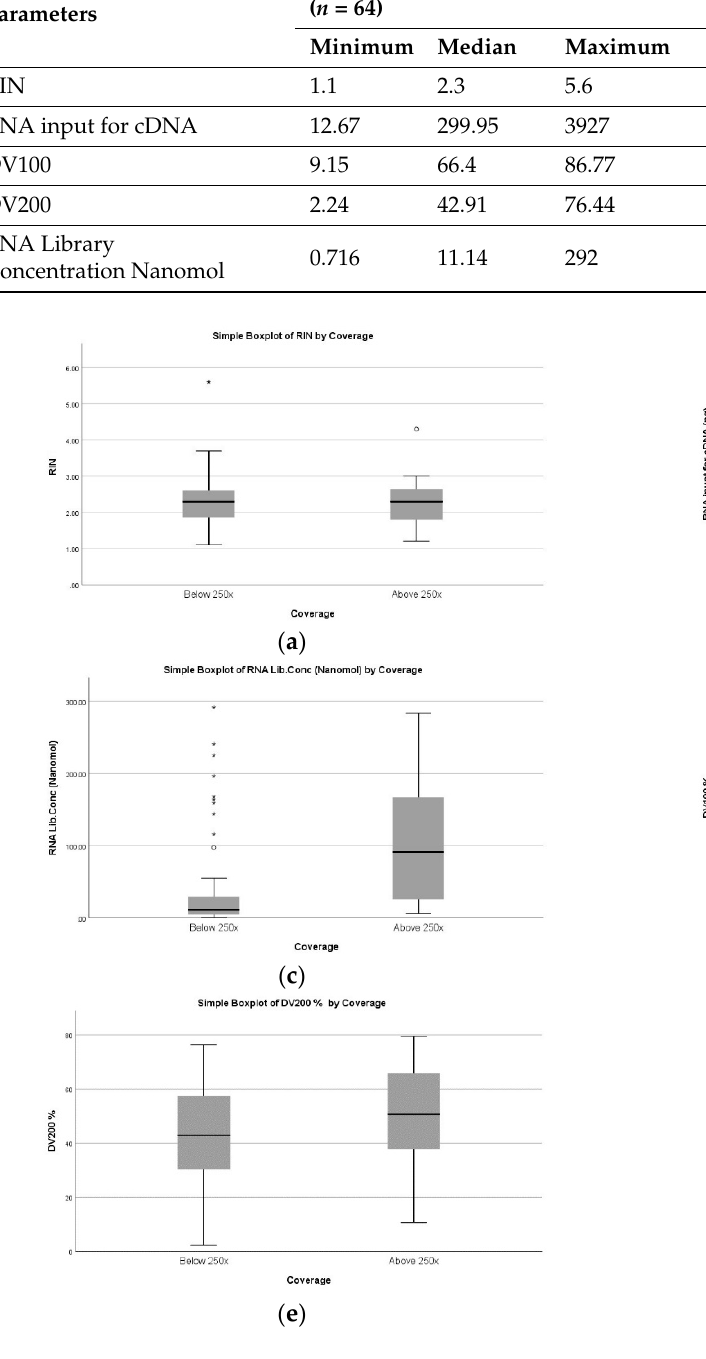
Figure 4. Graphical representation of FFPE RNA samples according to NGS coverage. ( a ): RIN, ( b ):